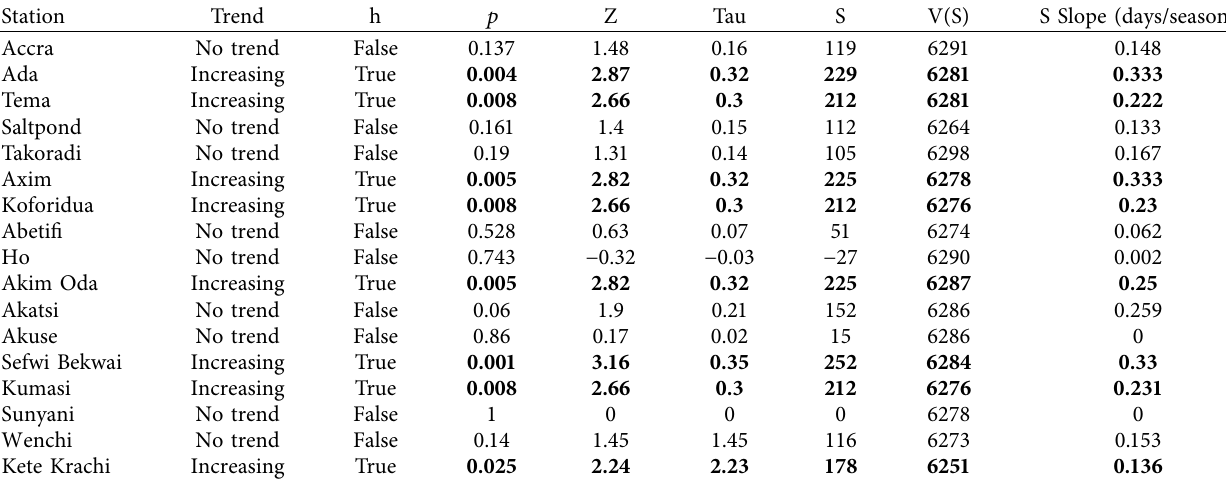
Table 5: Mann-Kendall trend analysis of frequency of rainfall occurrences.